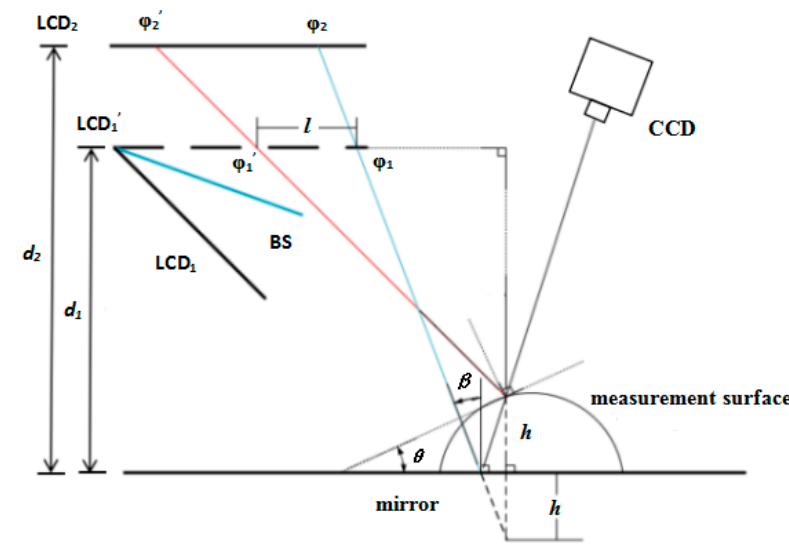
Figure 1. Schematic diagram of the measuring system using direct phase measuring deflectometry (DPMD). Figure 1 is a schematic diagram of the proposed full-field 3D shape measurement system for specular surfaces using the DPMD technique. The system consists of two LCD screens, one mirror, one CCD camera, and one beam splitter plate.